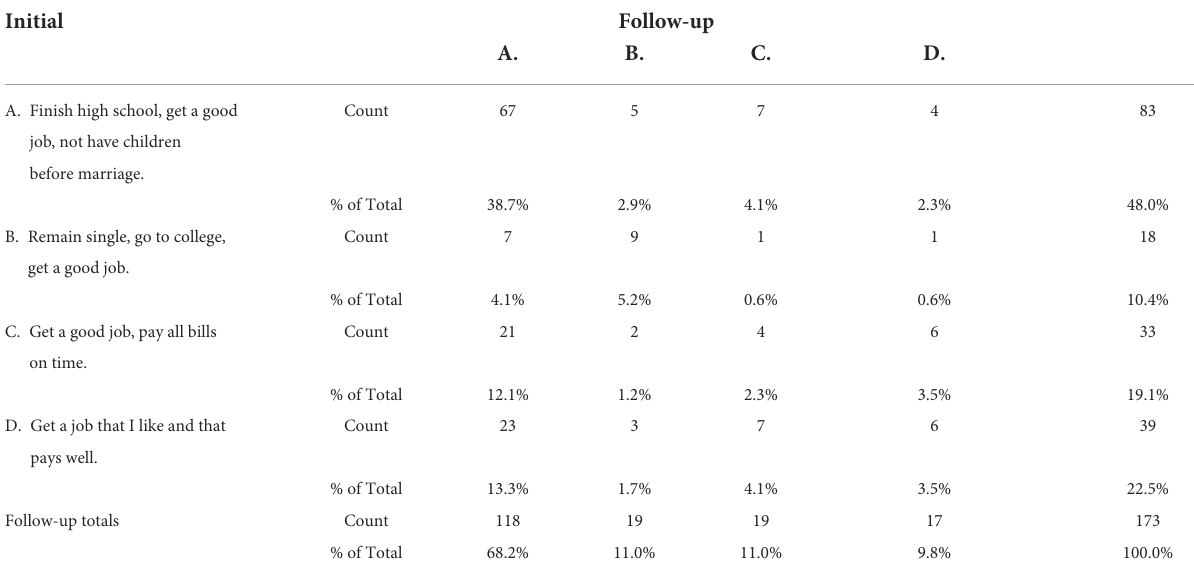
TABLE 1 Initial (pre-test) by follow-up (post-test) knowledge test item (Group 1). To have the most successful life a person should? Initial Totals Initial Follow-up